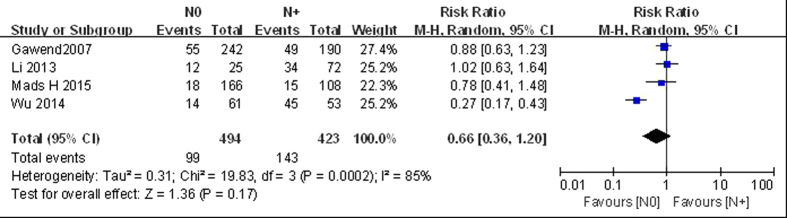
Forest plot of risk ratios of legumain overexpression in N0 vs N+ groups.